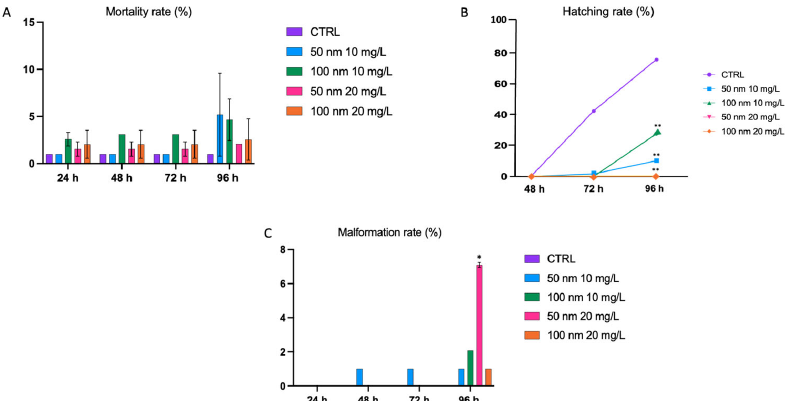
Figure 2. ( A ) Mortality rate of D. rerio embryos exposed to 50 and 100 nm nPS ‐ NH 2 at different concentrations compared to the control group. No statistical differences were found ( p > 0.05). ( B ) Hatching rate of D. rerio larvae exposed to 50 and 100 nm of nPS ‐ NH 2 at different concentrations